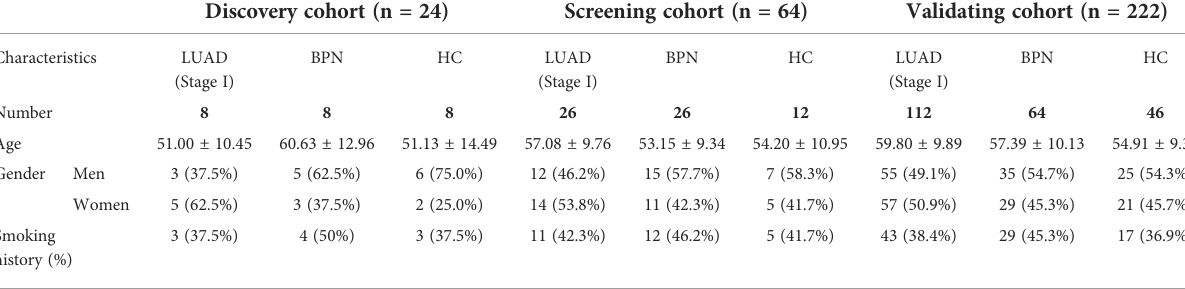
TABLE 1 Clinical characteristics of the discovery, screening, and validating